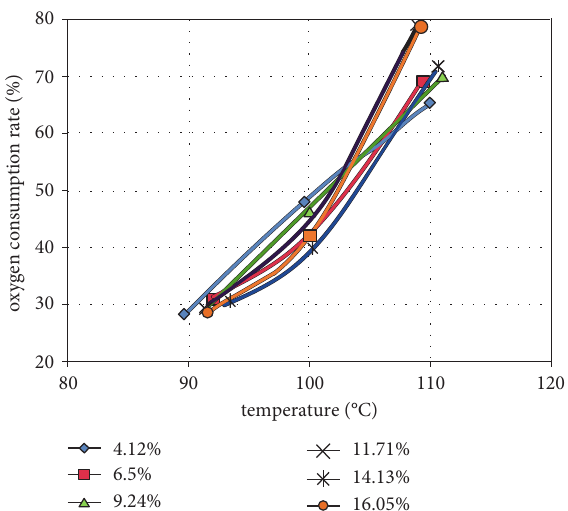
Figure 16: Evolution of CO concentration, as an index of coal spontaneous combustion, for samples with different moisture content in the temperature range of 90–110 ° C.